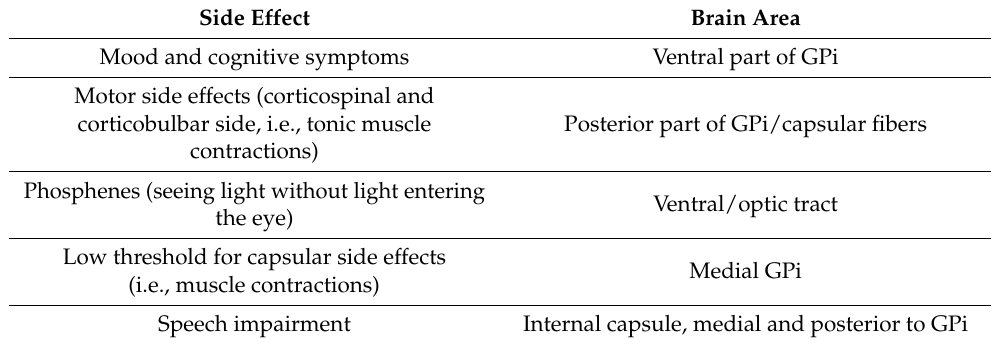
Table 4. Side effects of GPi DBS and the areas whose stimulation is responsible for these symptoms. Side Effect Brain Area Mood and cognitive symptoms Ventral part of GPi Motor side effects (corticospinal and corticobulbar side, i.e., tonic muscle Posterior part of GPi/capsular fibers contractions) Phosphenes (seeing light without light entering Ventral/optic tract the eye) Low threshold for capsular side effects Medial GPi (i.e., muscle contractions) Speech impairment Internal capsule, medial and posterior to GPi GPi—globus pallidus